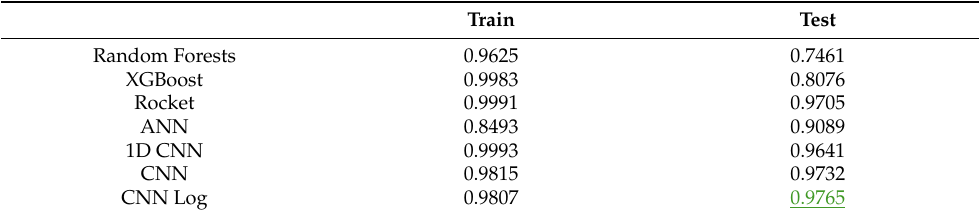
Figure 3. Boxplot showing the distribution of accuracy obtained by each method on the test set, in 30 independent runs of predicting the EC. Table 3. Median overall accuracy obtained by the different methods when predicting the different types of ECs on the training and test set. The best test result is represented in